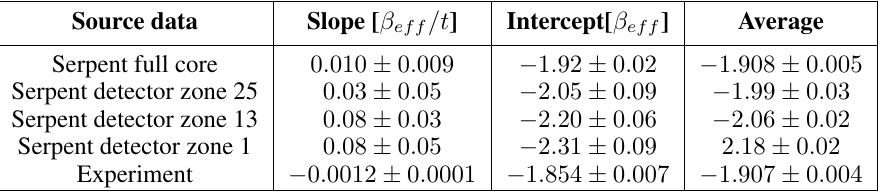
Table 1: Coefficients of linear fit for different cases with Asymptotic Standard Error